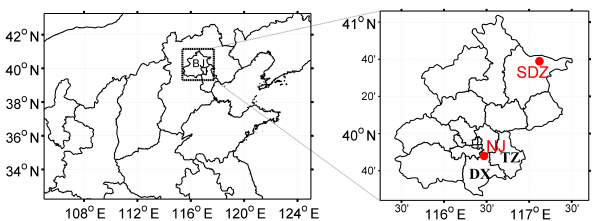
Figure 2. Left: model domain settings; right: the locations of Nanjiao (NJ) and Shangdianzi (SDZ) observation sites and the Tongzhou (TZ) and Daxing (DX)